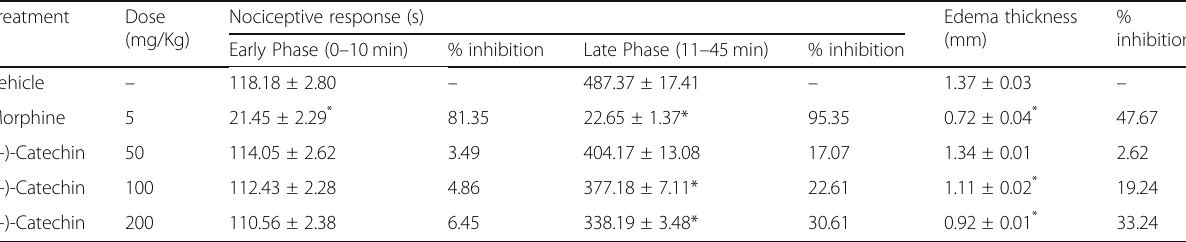
Table 2 Effect of catechin and morphine in formalin-induced nociception test Treatment